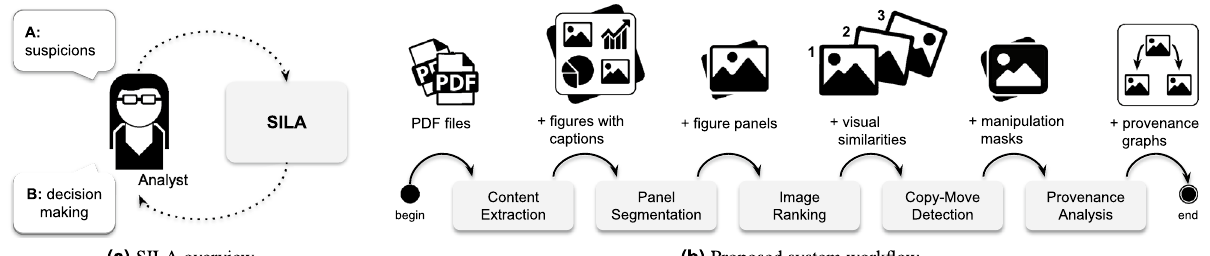
Figure 2. The SILA system. In ( a ), the devised operation of SILA, highlighting its human-in-the-loop aspect. An analyst who has suspicions about a set of scientific publications feeds them to the system as PDF